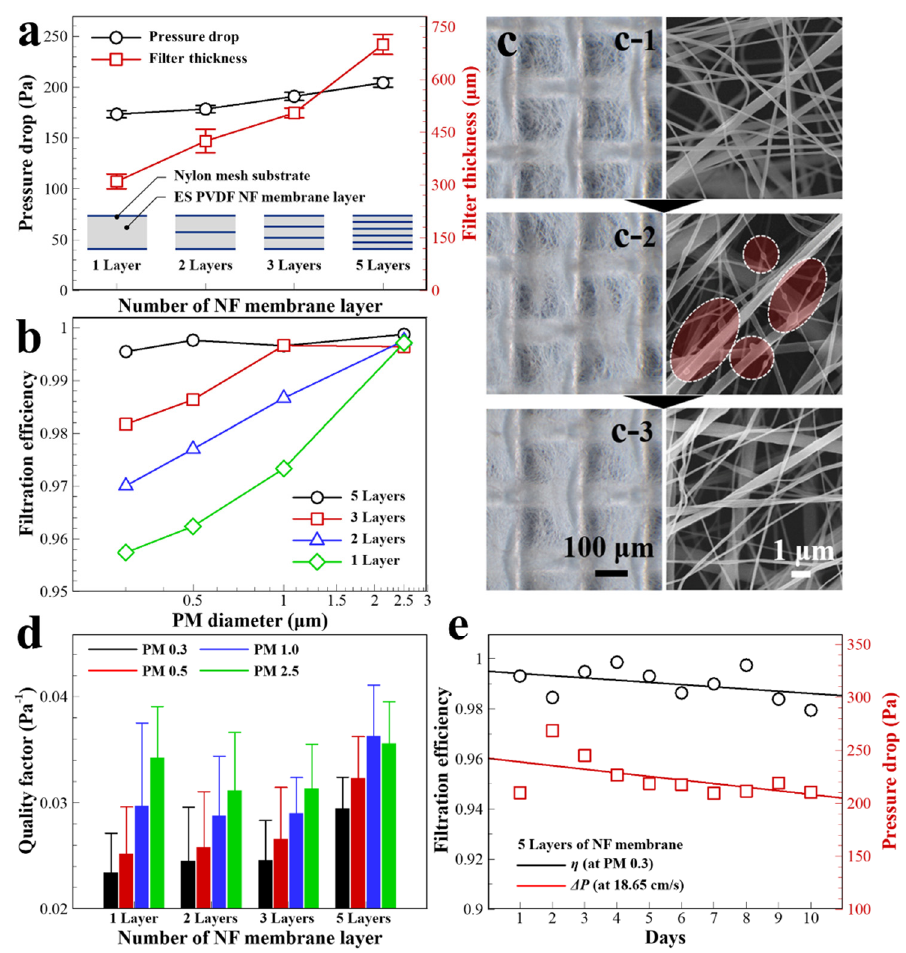
Figure 4. ( a ) Pressure drop of the multilayer NF filter depending on the layer composition. ( b ) Filtration efficiency of the number of layers in the multilayer NF filter for fine PM filtration. ( c ) OM and SEM images of the multilayer NF filter surface ( c-1 ) before filtration, ( c-2 ) after filtration, and ( c-3 ) regeneration by oven drying after ethanol dipping. ( d ) Characteristics of averaged QF at different PM sizes by surface charging after regeneration each day for 10 days. ( e ) Filtration efficiency and pressure drop variation of a quintuple-layer of NF membrane filter for 10 days.